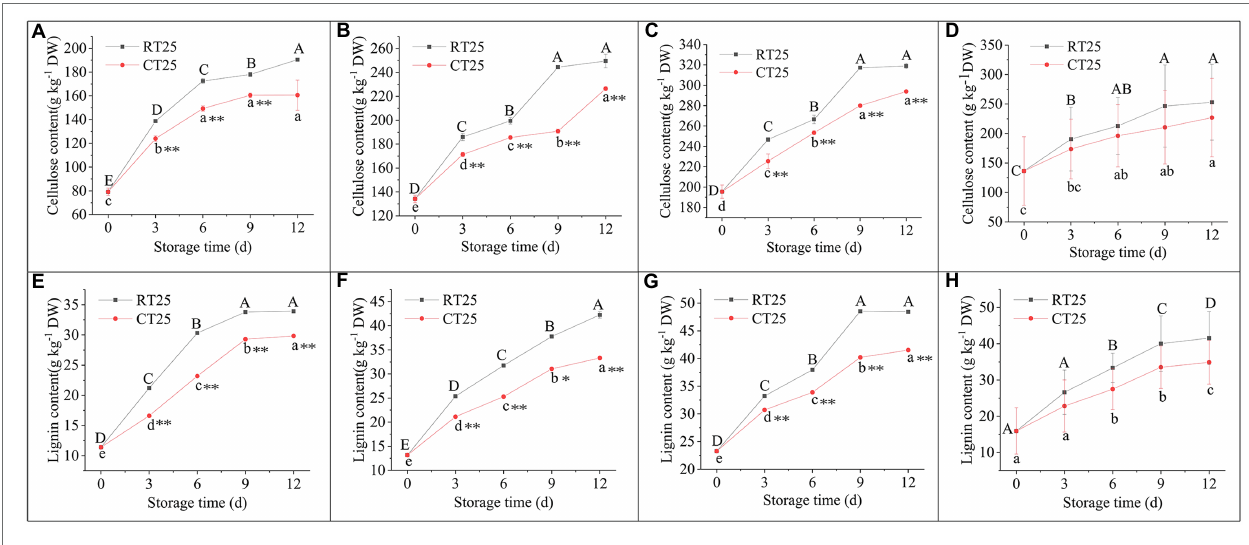
FIGURE 11 | Dynamic changes in cellulose and lignin content in shoots during storage at 25 ° C and 4 ° C. RT25, bamboo shoots stored at room temperature and analyzed at 25 ° C; CT25, bamboo shoots stored at cold temperature and analyzed at 25 ° C. (A–D) Cellulose content in shoots during storage for upper (A) , middle (B) , and bottom (C) plant parts, and mean values (D) . (E–H) Changes in lignin content in shoots during storage for upper (E) , middle (F) , and bottom (G) plant parts, and mean values (H) . Mean values were the mean values of upper, middle, and bottom plant parts from different treatments. Data are presented as mean ± standard deviation ( n = 3). Significant analysis was performed using the Student’s t -test, in which different letters represent significant difference between treatments within the group, and the asterisk represents the level of significance between groups ( * means the difference is significant at the 0.05 level, ** means the difference is significant at the 0.01 level).